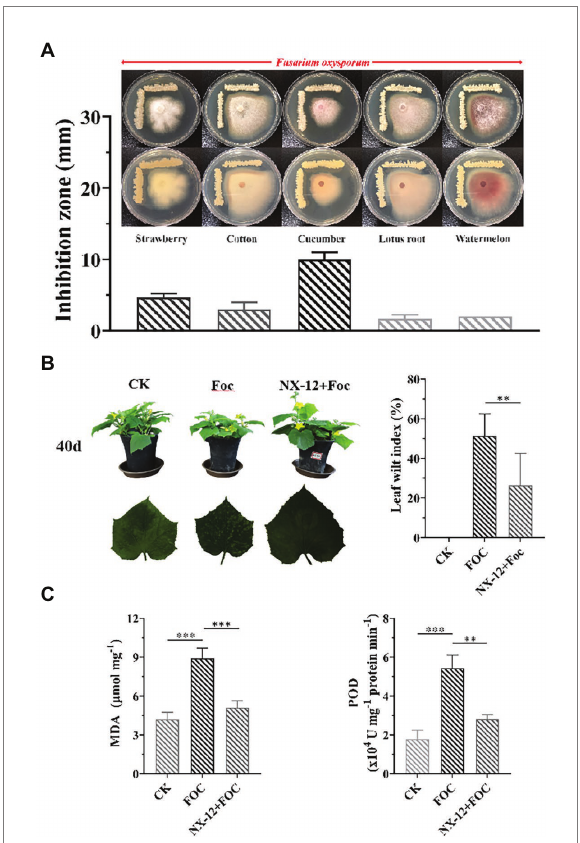
FIGURE 1 Antifungal activity and biocontrol efficacy of Bacillus atrophaeus NX-12. (A) The inhibitory effect of NX-12 on Fusarium oxysporum of different plant specialization types; (B) Biocontrol efficacy of strain NX-12 against Fusarium wilt in cucumber; (C) Activities of MDA and POD in Cucumber Leaves. Error bars represent standard deviations. ** indicated value of p < 0.01; *** indicated value of p <